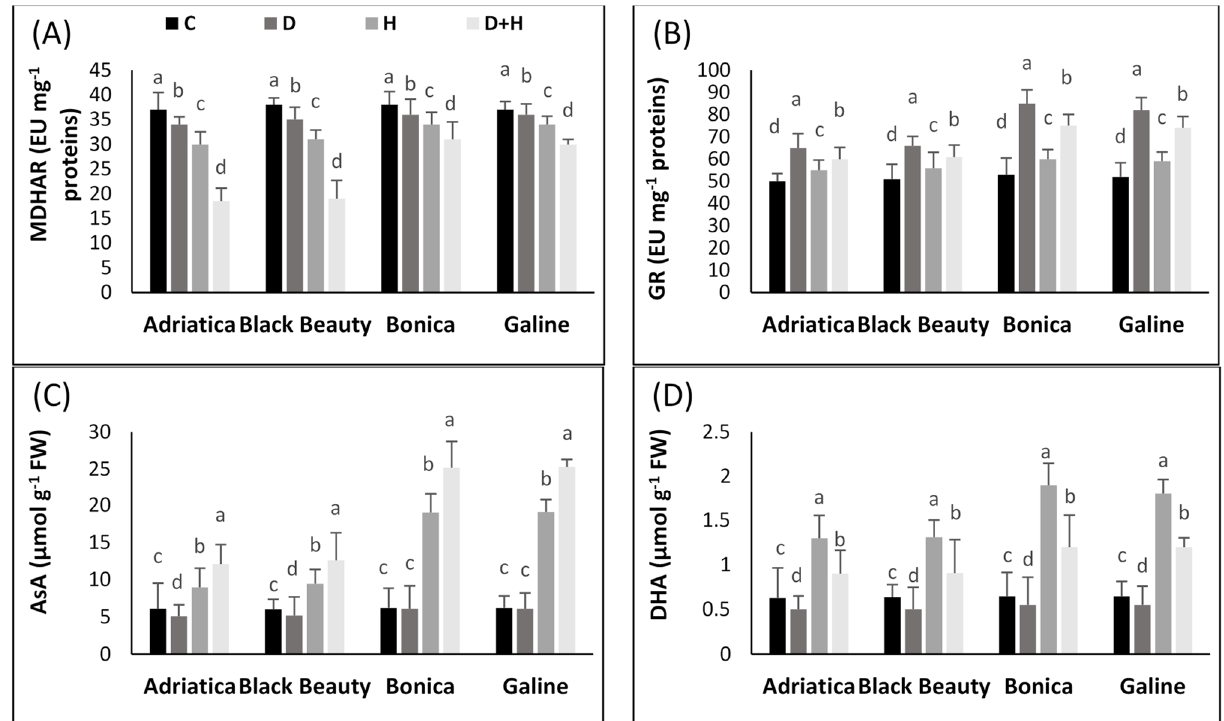
Figure 5. Variations in ( A ) Monodehydroascorbate reductase (MDHAR), ( B ) glutathione reductase (GR), ( C ) ascorbic acid (AsA), and ( D ) dehydroascorbate (DHA) of four eggplant cultivars under individual and combined stresses. The data are the means ± SE ( n = 5). Significant dissimilarities are shown by different lower-case letters between treatments ( p ≤ 0.05) based on Tukey’s test. (C, control; H, heat stress; D, drought stress; H + D, heat + drought stresses).